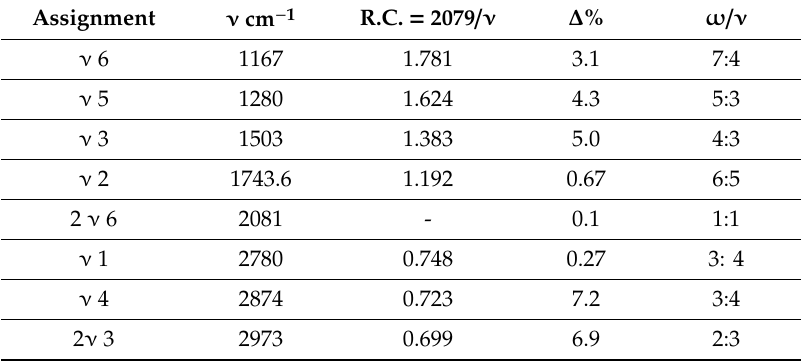
Table 1. Treatment of observed vibrations of H 2 CO.